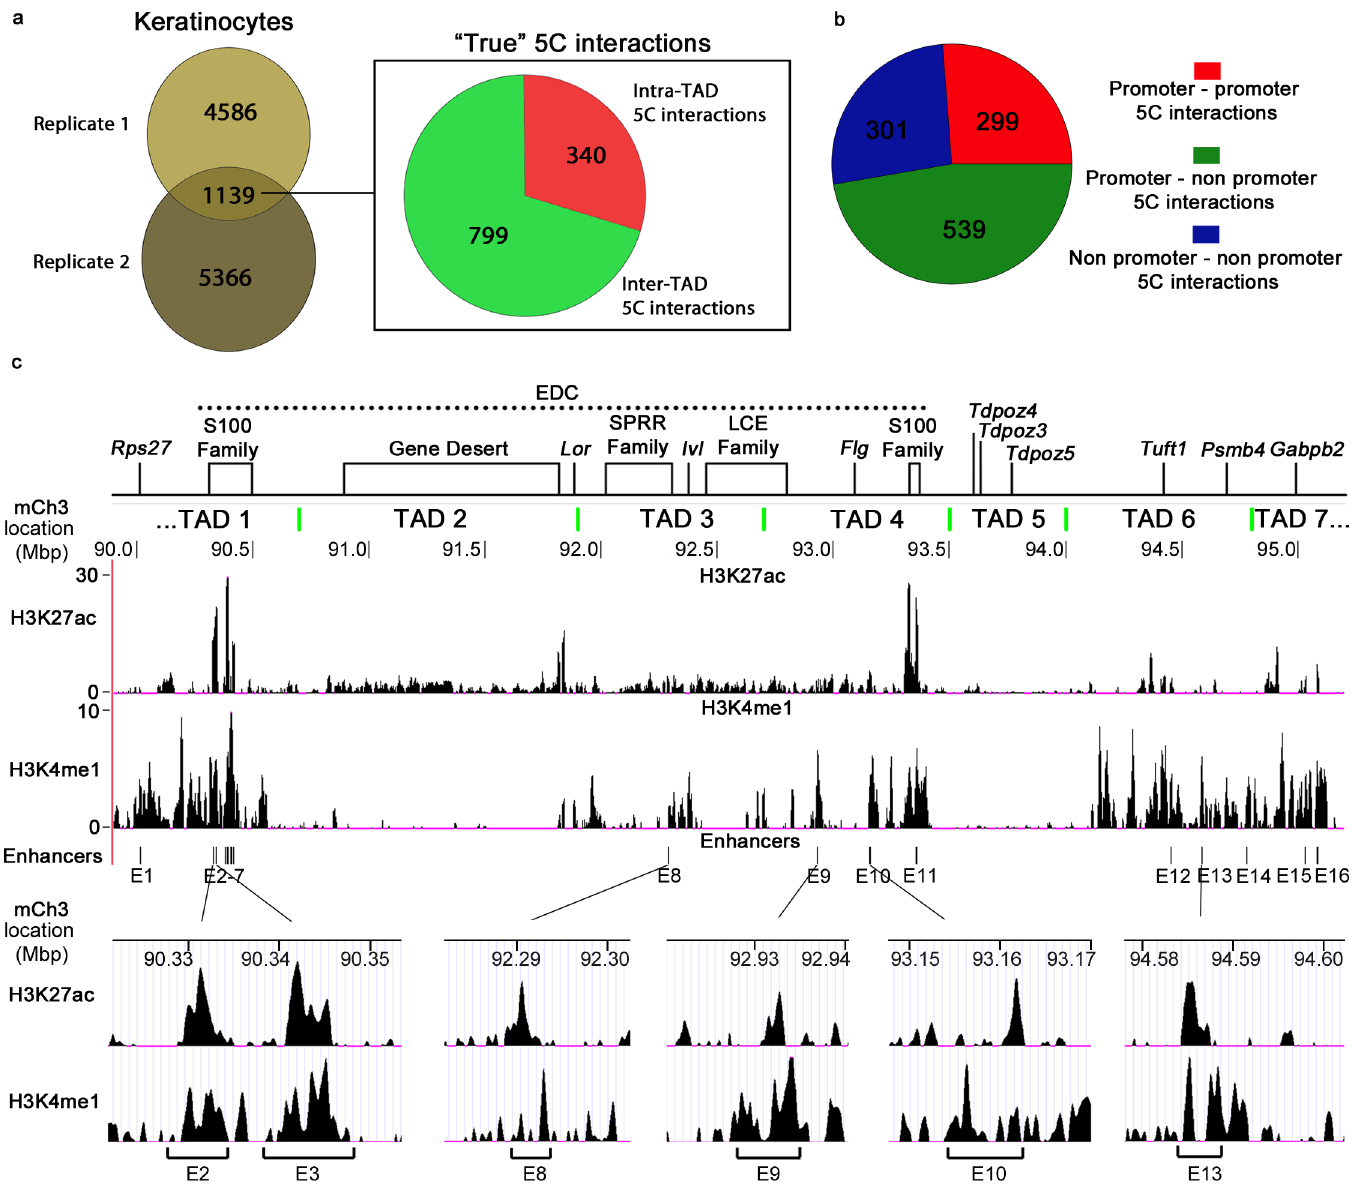
Fig 3. 5C looping interactions at the EDC locus involve gene promoters and enhancers in keratinocytes. (a) Vent diagram indicating the overlap of the significant5C interactions(q < 0.05)betweenthe 5C library replicatesand pie chart showingthe numberof all “true” intra-TAD (red) and inter-TAD (green) 5C interactionsin KCs. (b) Pie-chart indicatingnumber of 5C interactions connectingtwo regions anchoring transcriptionstart sites (TSSs) within 5kb (promoter-promoterinteractions); one contactingregionanchoringa TSS within 5kb and the other contacting region not anchoringa TSS within 5 kb (promoter-non promoterinteractions); and both contactingregions not anchoring TSSs within 5kb (non-promoter–nonpromoter interactions). (c) Genome browserimages of the normalized ChIP-seq signals for H3K4me1 and H3K27acenrichment as well as the positionof the putative gene enhancersat the EDC containing locus in KCs alignedto the schematic locus map. Genome browserimages of the normalized ChIP-seq signalsfor several enhancer regions at small scale are providedas examples. See Materials and Methods section for details of ChIP-seq peak callingand pursing the putative enhancers. The TAD border midpointsare indicatedby the green